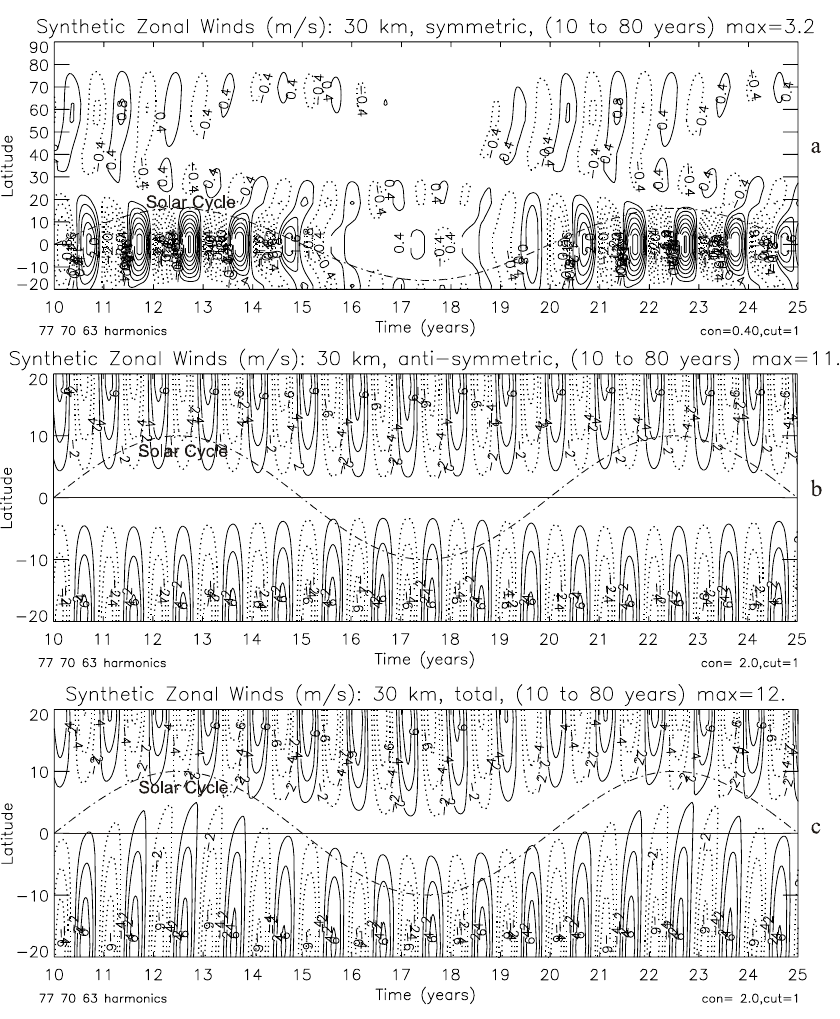
Fig. 8. (a) Like the QBO, the SC modulated symmetric EAO is largely confined to low latitudes (the contour interval is 0.4m/s). (b) In contrast to the EAO, the dominant anti-symmetric annual oscillation vanishes at the equator, increases towards mid latitudes, and the SC signature is weak. (c) When the symmetric and anti-symmetric annual oscillations are combined, the resulting SC modulations are pronounced and differ in magnitude and phase in the Northern and Southern Hemispheres (as in b, the contour interval is